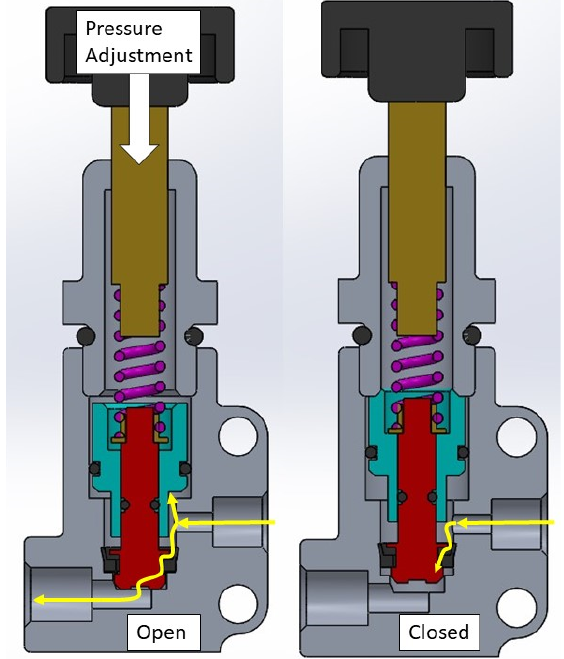
Figure A1. Isometric and section view of Wilwood 260-8419 proportioning valve in the open and closed position. The yellow line shows the flow path. Outlet pressure is reduced to 44% of the inlet pressure in the full closed position.